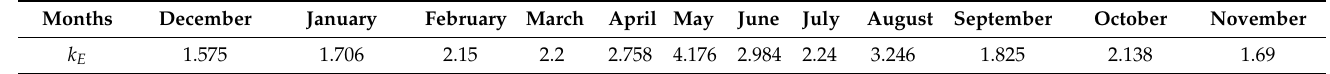
Table 5. Coefficient reduction in cost of electricity consumed from the grid.